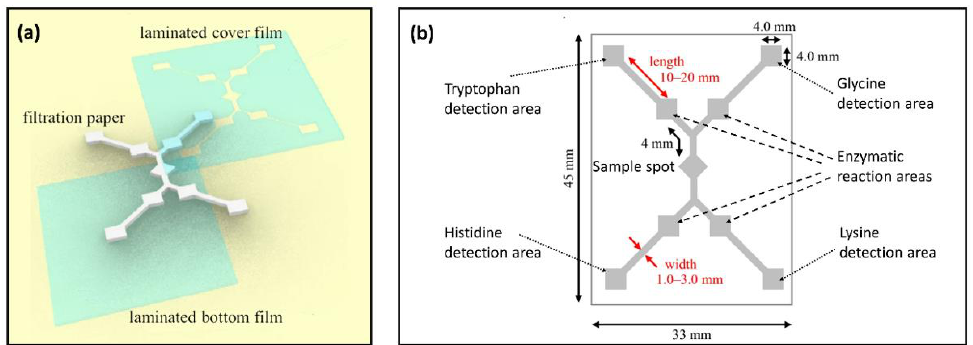
Figure 20. ( a ) Representation of the fabrication of a laminated paper‑based analytical device (LPAD) for the simultaneous quantification of tryptophan, glycine, histidine, and lysine levels in the range of a few micromolar to 100 uM by reactions of sample-specific aminoacyl – tRNA synthetases. ( b ) Details of the LPAD. The paper properties and dimensions of channels between detection and reaction areas specify the incubation time for the reaction mixture. Reprinted with permission from [427] (open access).